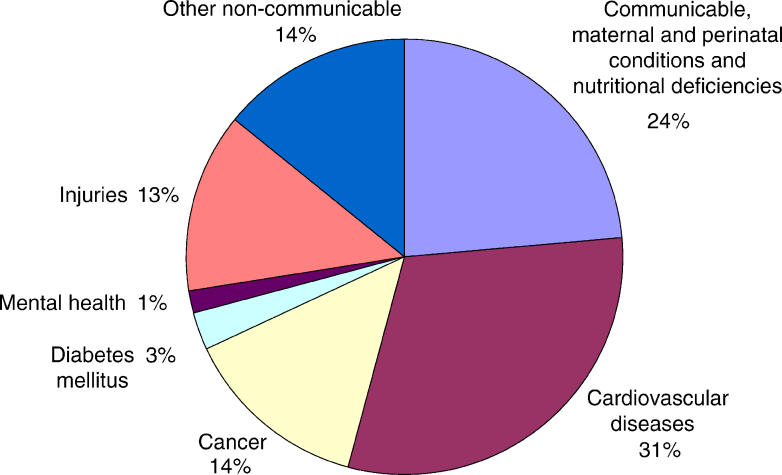
Distribution of Total Deaths (3,537,000) by Major Causes in LAC Countries in 2000, Estimated by the Global Burden of Disease StudyThe Latin American and Caribbean countries included are Anguilla, Antigua and Bermuda, Argentina, Aruba, Bahamas, Barbados, Belize, Bolivia, Brazil, British Virgin Islands, Cayman Islands, Chile, Colombia, Costa Rica, Cuba, Dominica, Dominican Republic, Ecuador, El Salvador, French Guiana, Grenada, Guadalupe, Guatemala, Guyana, Haiti, Honduras, Jamaica, Martinique, Mexico, Montserrat, Netherlands Antilles, Nicaragua, Panama, Paraguay, Peru, Puerto Rico, Saint Kitts and Nevis, Saint Lucia, Saint Vincent and the Grenadines, Suriname, Trinidad and Tobago, Turks and Caicos Islands, Uruguay, US Virgin Islands, and Venezuela.